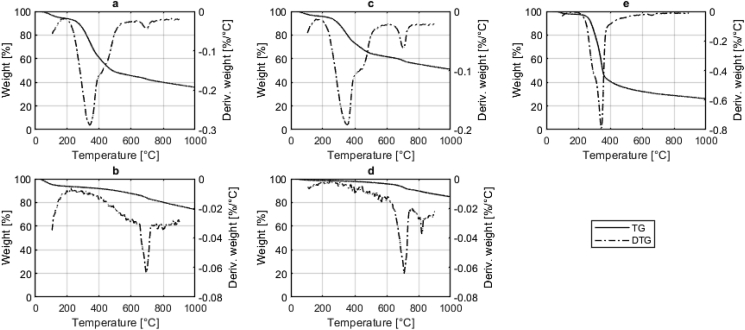
TG and DTG results from N-FS (a), N-CBC (b), W-FS (c), W-CBC (d) and PF (e).